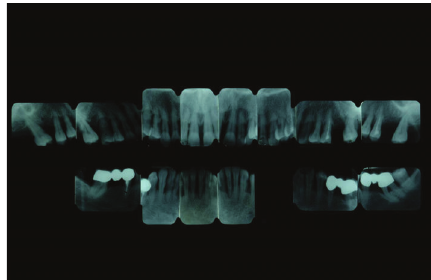
Figure 4: Initial case: full-mouth intraoral radiographic exam (May